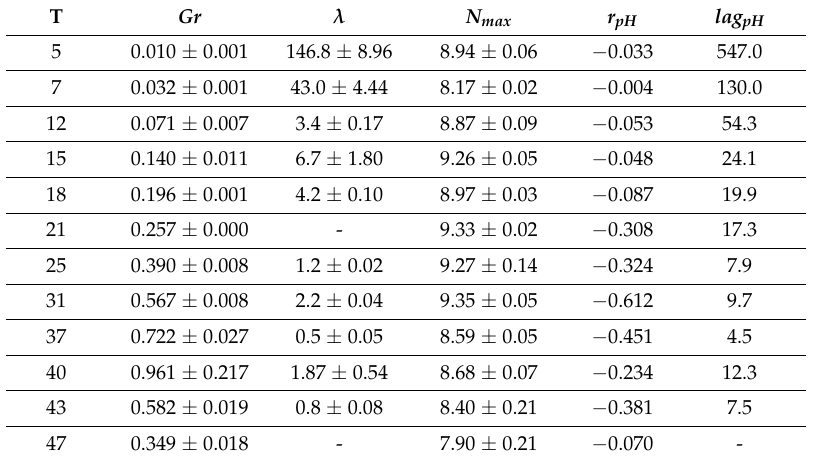
Table 1. Effect of temperature on the growth and metabolic activity of Fresco culture in